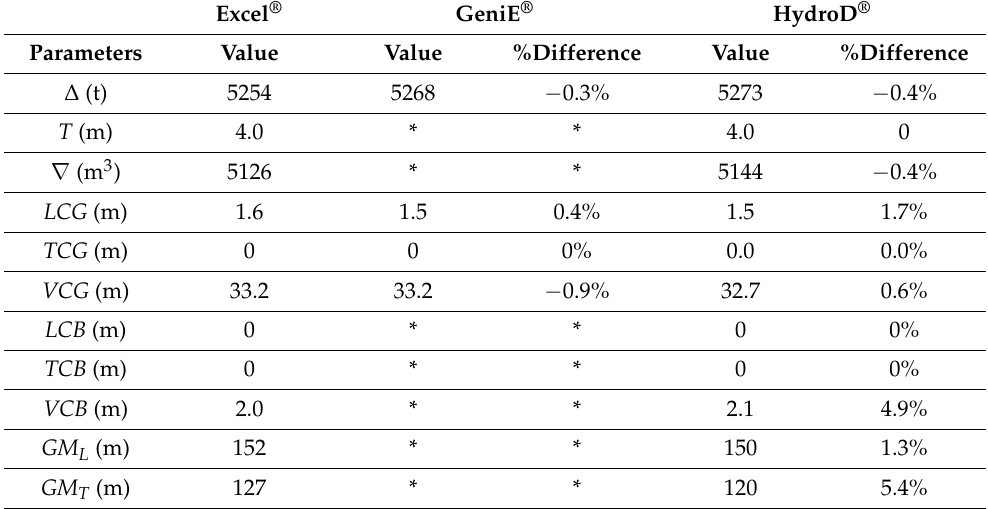
Table 6. Results of Validation Process, SA: